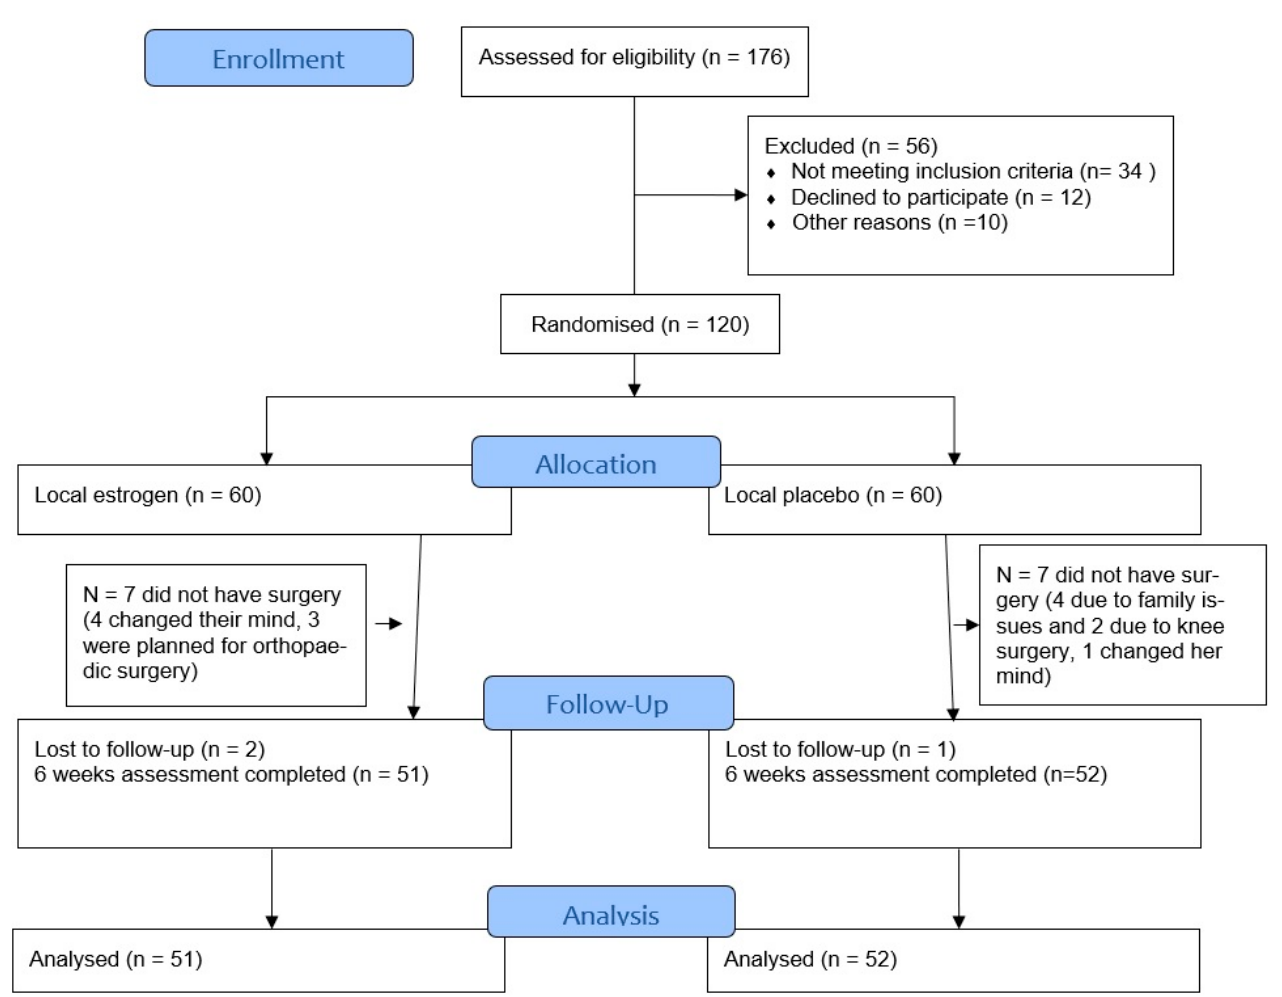
Figure 1. Flow of participants through the trial.